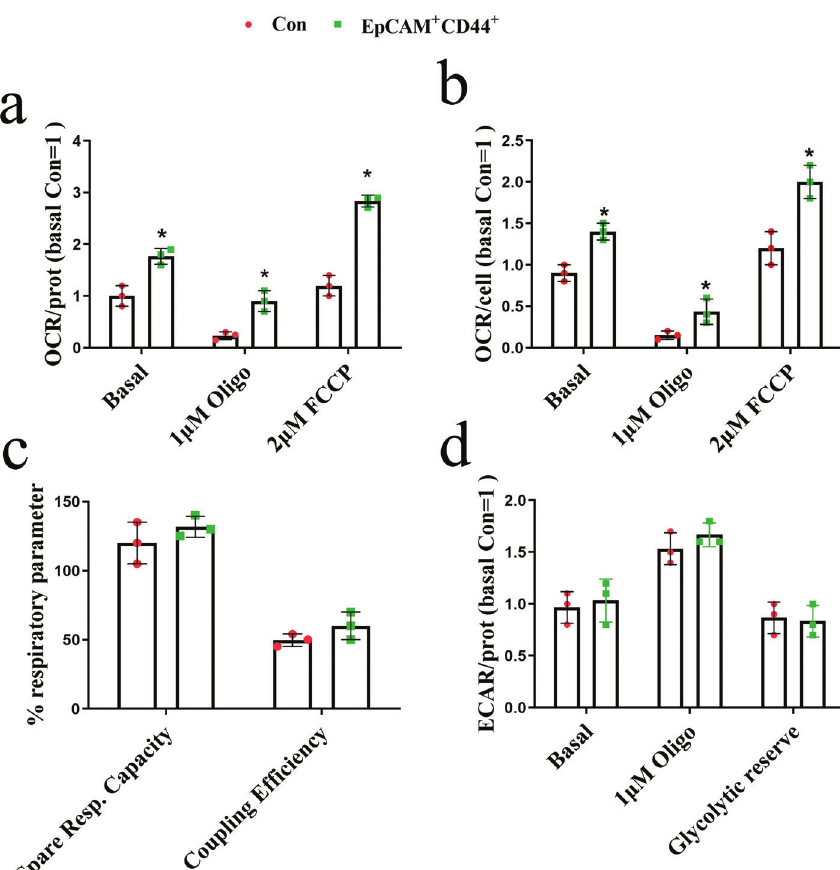
Fig. 1. Metabolic characteristics of EpCAM + CD44 + cells and control cells. OCR of EpCAM + CD44 + cells, determined by Seahorse Mito stress test (a) and oxygraph (b) analysis. (c) Spare respiratory capacity and coupling efficiency of EpCAM + CD44 + cells. (d) Extracellular acidification rate (ECAR) parameters derived from the analysis of Seahorse glycostress test, normalized on basal glycolytic parameters of control. Results are expressed as mean ± SD ( n = 3). * P < 0.05 versus